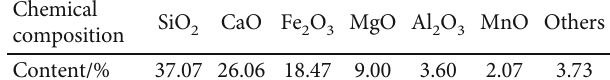
Table 1: Chemical composition and content of tailing sand.